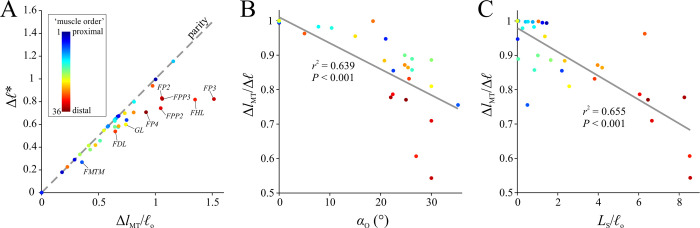
Ranges of normalized fibre lengths and MTU lengths across all viable limb poses.The results illustrated here are for static simulation 1, but a very similar pattern was achieved for the other three simulations as well. (A) Range of normalized fibre length compared to range of MTU length (normalized by optimal fibre length) for each MTU; all points plot on or below the line of parity, with the most extreme outliers indicated (see Table 2 for abbreviations). (B) Ratio of MTU length range to fibre length range compared to pennation angle. As fibre length range can at most be equal to MTU length range, this ratio is one or less; the lower it is (i.e., the further a point plots further from the line or parity in A), the greater the discrepancy between length changes at the level of the MTU and fibre. A higher pennation angle leads to a greater decoupling between changes in fibre and MTU lengths. (C) Ratio of MTU length range to fibre length range compared to relative tendon length, expressed as the ratio of slack to fibre length. A relatively longer tendon leads to a greater decoupling between changes in fibre and MTU lengths. In all panels, points are colour coded by the order of muscles as listed in Table 2, which are arranged in a proximal-to-distal fashion.